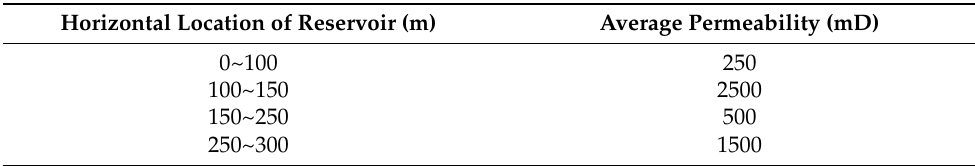
Table 1. Data table of permeability distribution in the horizontal section of well N1H. Horizontal Location of Reservoir